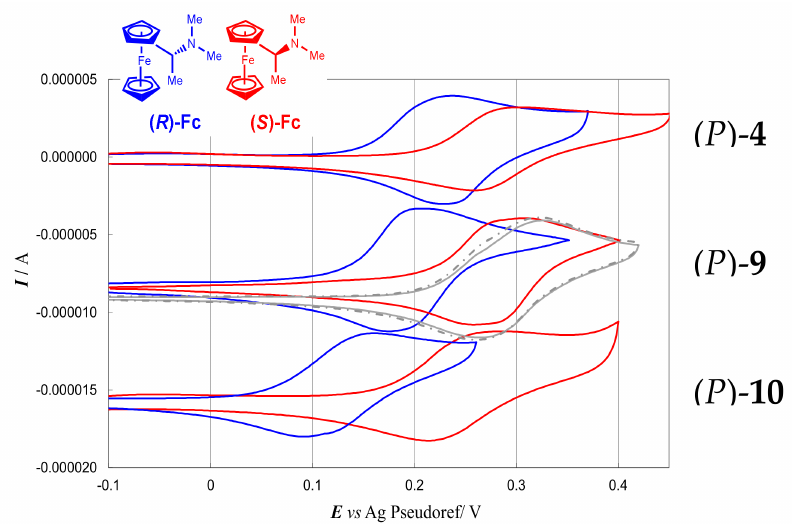
Figure 10. A synopsis of the CV features of ( R )-Fc (blue line) and ( S )-Fc (red line) solutions on graphite SPE in (BMIM)NTf 2 with ( P )- 4 , ( P )- 9 and ( P )- 10 as low concentration chiral additives (0.02 M). In grey the voltammograms referred to experiments in absence of inherently chiral salts are also